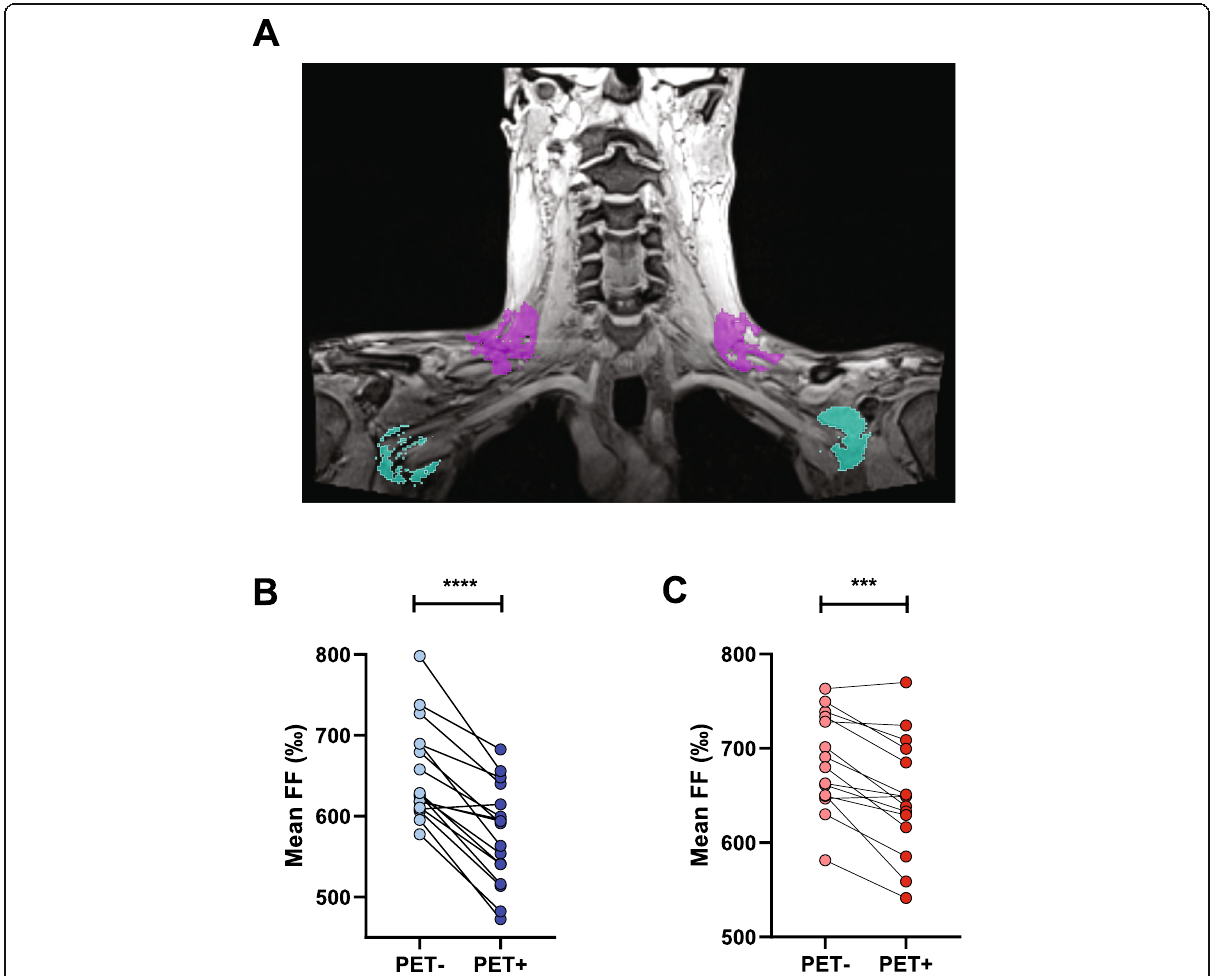
Fig. 3 Comparison of the fat fraction in PET-negative and PET-positive areas within the supraclavicular adipose tissue depot. a Placement of spherical region of interest in PET-negative (turquois) and PET-positive (pink) area of supraclavicular adipose tissue. b Study cohort 1, p < 0.0001 and c study cohort 2, p = 0.0002 (paired t